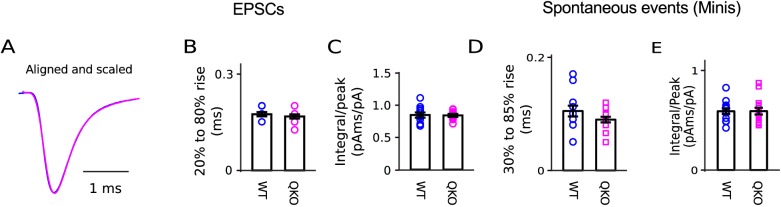
No difference in shape of EPSC at QKO calyces of Held. (A) Scaled overlay of traces in Figure 2B. (B) Quantification of 20% to 80% rising phase of EPSCs. (C) Quantification of shape of EPSCs by dividing the current integral by the peak . (D and E) Quantification of shape of spontaneous events documented in Figure 2D–F.